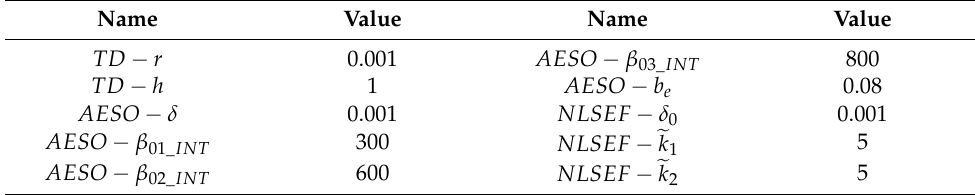
Table 8. Parameters of